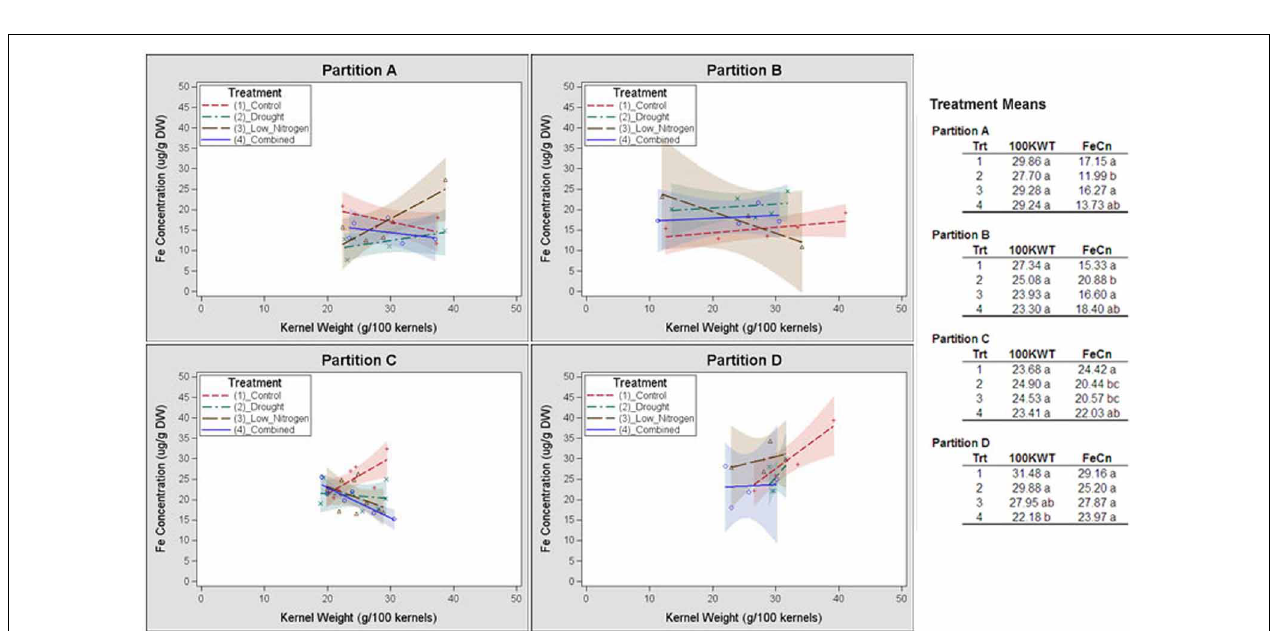
members. Factors used to distinguish subclasses are listed at the base of the node or data split; members of each partition are indicated within the box by levels of the splitting factor. Average values represent a combined kernel Fe concentration and weight variable, generated by partition analysis as indicated in methods section. The four inbred partitions representing genotype groupings with similar kernel Fe concentration and weight responses to environmental treatment are indicated with italic labels as partitions A , B , C , and D .